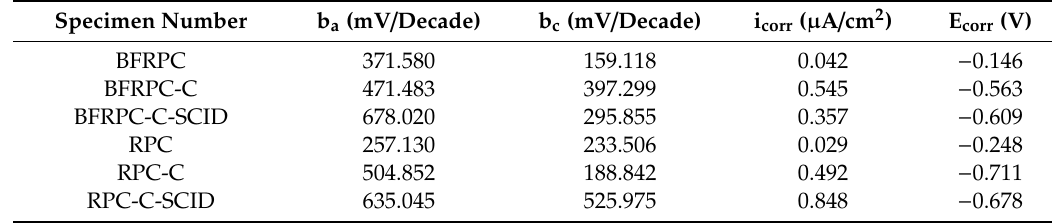
Table 4. Electrochemical parameters of the Tafel curve.